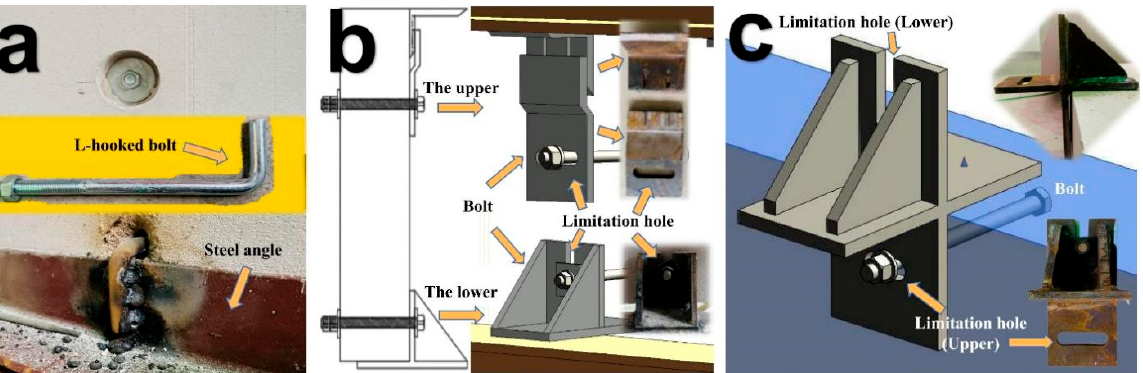
Figure 1. ALC panel connectors: ( a ) L-hooked bolt; ( b ) Pendulous Z-panel connector; ( c ) Crossing panel connector.